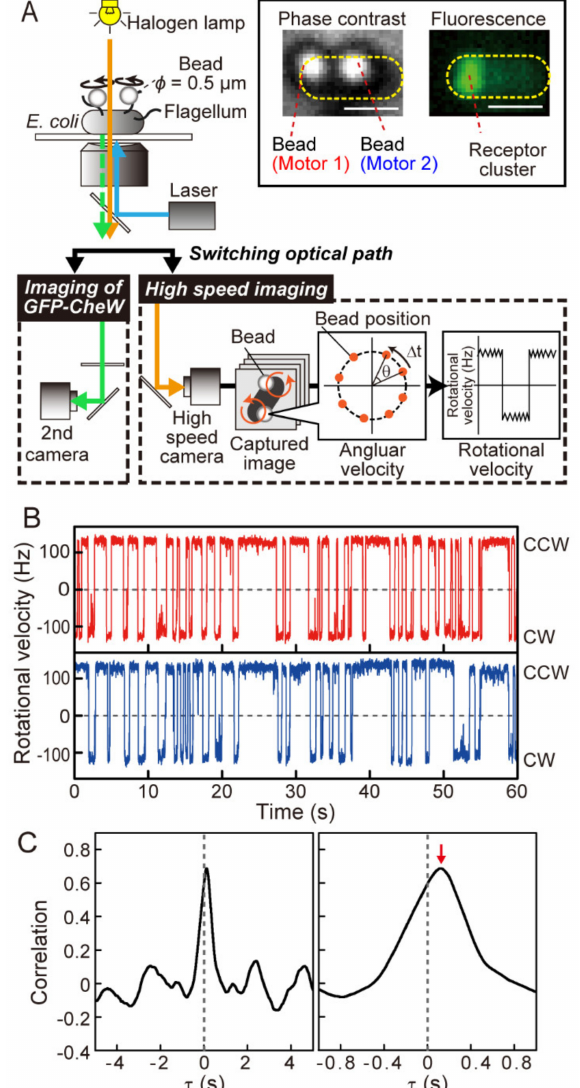
Figure 1. Coordination of steady-state switching of flagellar motors on a wild-type (CheA S + ) cell. ( A ) Schematic diagram of the measurement system. The cell was stuck to a coverslip, and polystyrene beads ( ϕ = 0.5 µ m) were attached to the sticky flagellar stubs to calculate the angular velocity of the motor from the position of each bead. The phase-contrast image of each bead was recorded with a high-speed charge-coupled device (CCD) camera (1250 or 1255 frames / s). A time trace of rotational velocity and rotational direction of the motor was calculated from the bead position in each sampling frame. The fluorescence image was recorded with a second CCD camera by switching optical path. Phase-contrast images of the cells and beads (left inset) and fluorescence imaging of the cells (right inset) are also shown. Bar, 1 µ m. The yellow-dotted ellipses indicate the cell bodies, and the positions of motors 1 and 2 are approximated from the position of the beads to which they are attached. The position of the polar receptor array was determined by the localization of GFP-fusion of CheW (GFP-CheW). ( B ) The time traces of the rotational velocities of motors 1 (red: proximal to the receptor array) and 2 (blue; distal from receptor array) on a wild-type (CheA S + ) cell. The plus and minus values represent counterclockwise (CCW) and clockwise (CW) rotations, respectively. ( C ) Cross-correlation profile between the time traces of motors 1 and 2, which are depicted in ( B ) (left), with a magnified version of it (right). The analysis was based on proximal motor 1. Correlations were calculated using Equation (1), as shown in the Materials and Methods. The red arrow indicates the time of peak correlation ( ∆ τ correlation = + 0.121